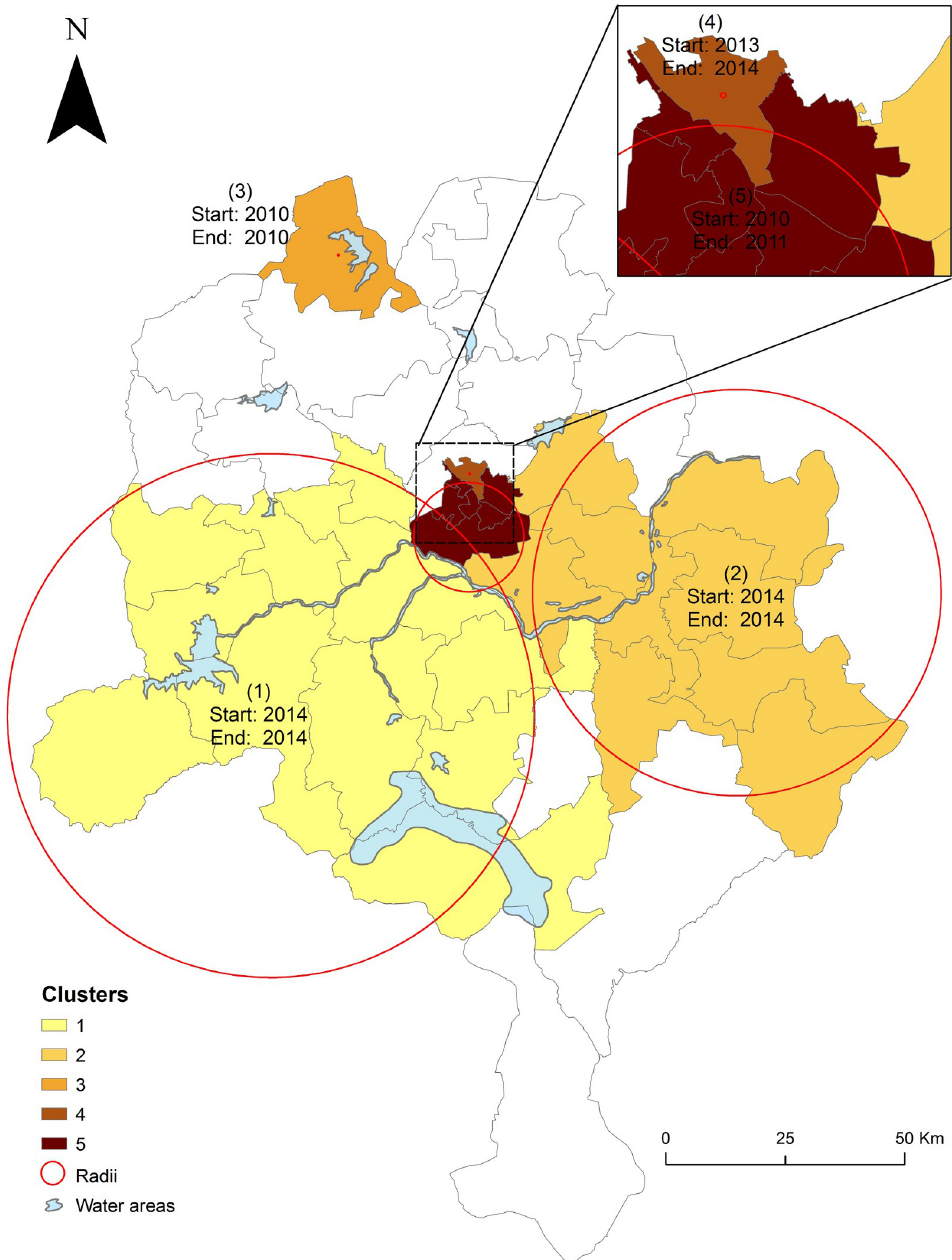
Fig 4. Spatio-temporal clusters of reported cholera cases in Kano State, 2010–2019. Map visualizes the space-time dynamics of reported clusters, which varied considerably in magnitude (size) and duration (time). Numbers 1–5 indicate clusters. Clusters 4 and 5 involve urban areas while the rest are located in the rural areas. The big circle shows a (1) large cluster with radius of 55.09 Km spanning 14 LGAs while the small circle indicates a (2) cluster of radius 42.72 Km involving nine LGAs. The smallest circle depicts a (5) cluster with radius of 11.49 Km involving six LGAs; the rest of the clusters (two LGAs) had zero radius, as indicated by the dots (red). Analysis used space-time windows of 25% of the population at-risk of cholera and 25% of the study time period, respectively, and default settings elsewhere. Here cholera cluster/hotspot means a geographically limited area where environmental, cultural and/or socioeconomic conditions facilitate the transmission of the disease and where cholera persists or reappears regularly. The insert shows a better view of the urban area clusters.